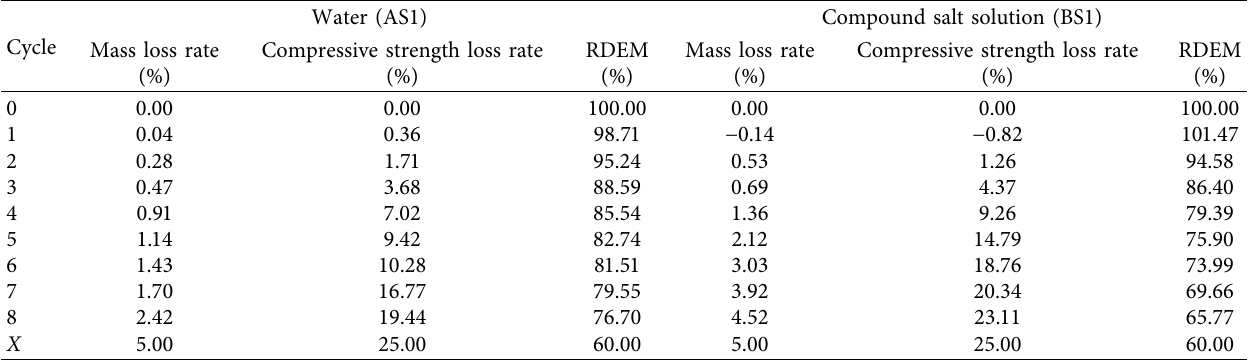
Table 3: Group S 1 test data after adding the X th cycle.